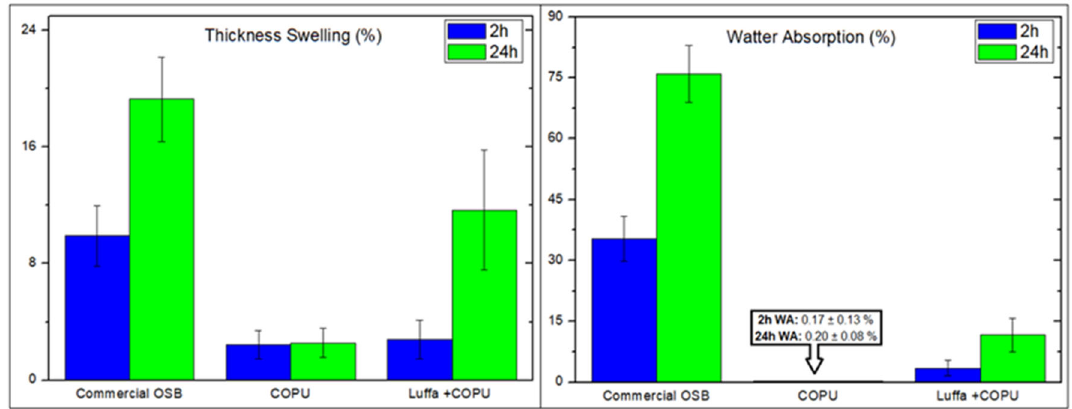
Figure 6. Water absorption (WA) and thickness swelling properties after 2 and 24 h for the commercial OSB, plain COPU, and luffa ‐ reinforced COPU composite.